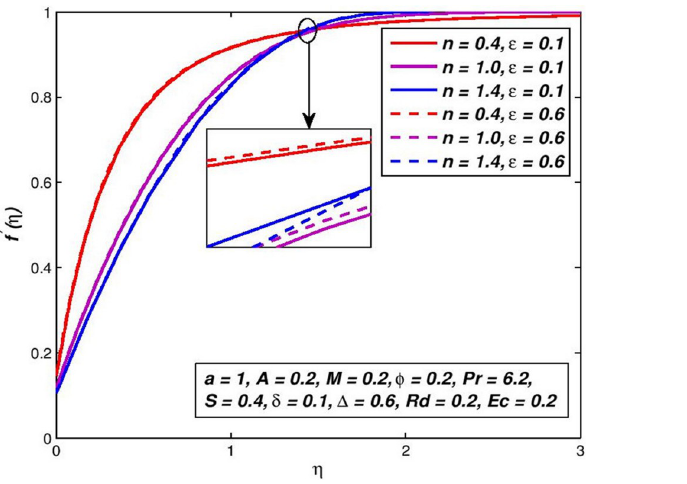
Fig 6. Effect of ε on f 0 ( η ) for diverse n